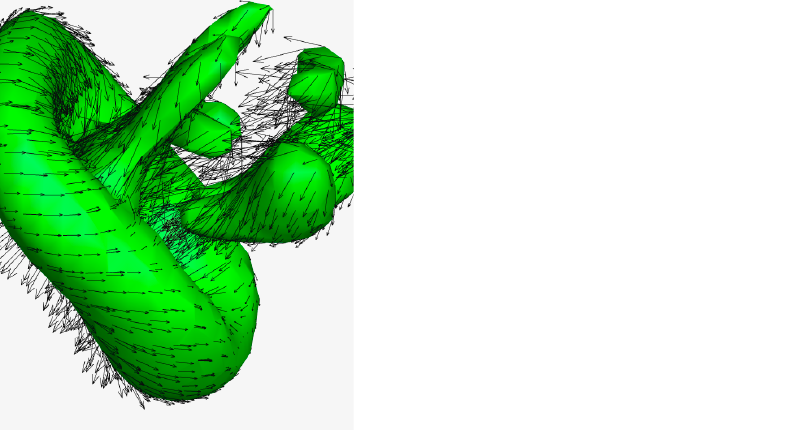
Figure 5. The shape of vortex structures and their surrounding tangential vectors.